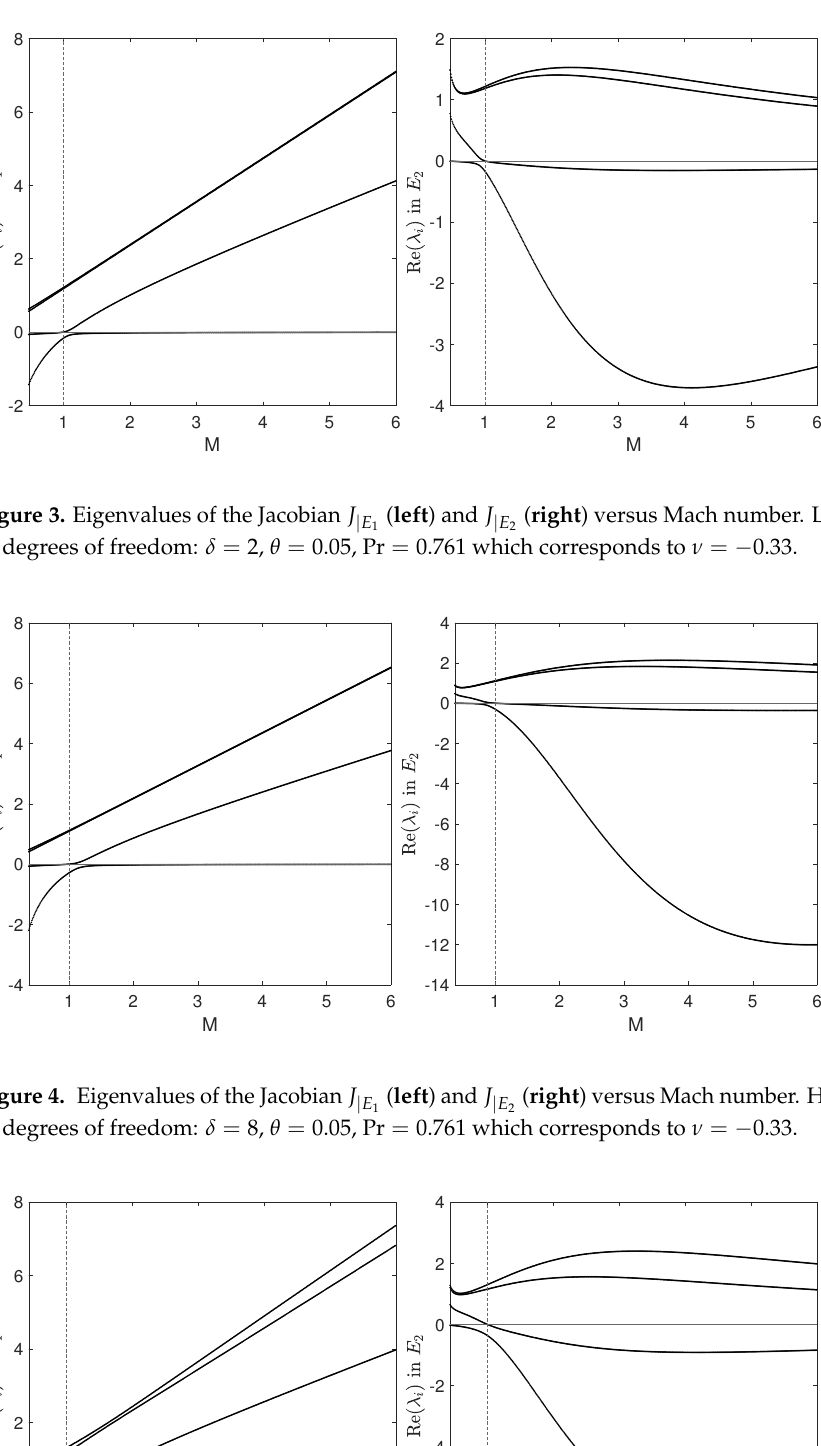
( left ) and J | E ( right ) versus Mach number. Higher value 2 1